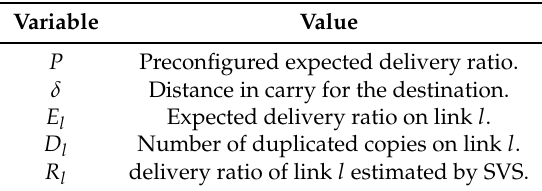
Table 1. Notations on Adaptive Packet Duplication